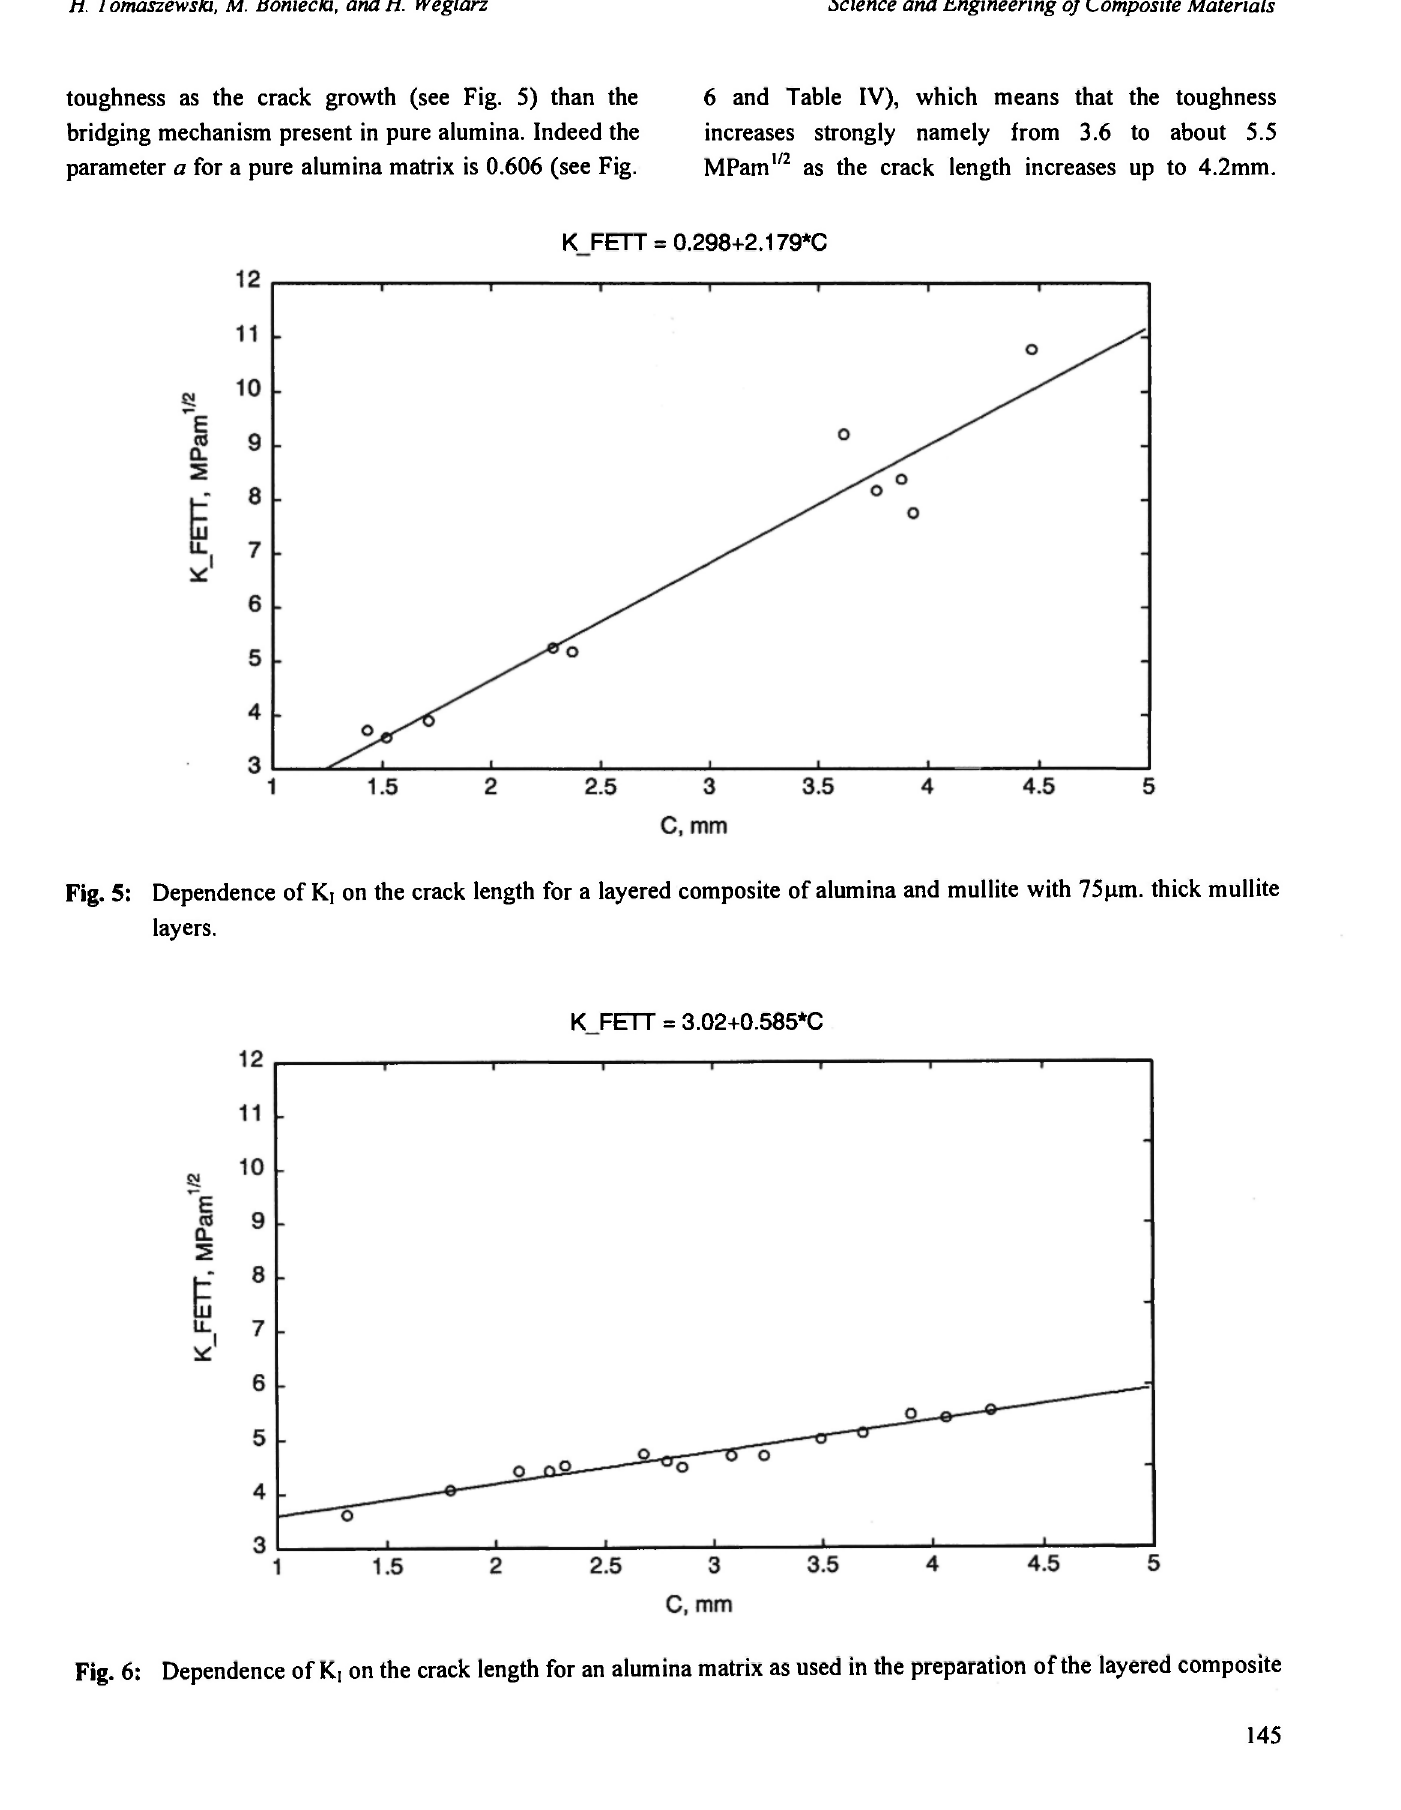
Fig. 6: Dependence of Κ, on the crack length for an alumina matrix as used in the preparation of the layered composite